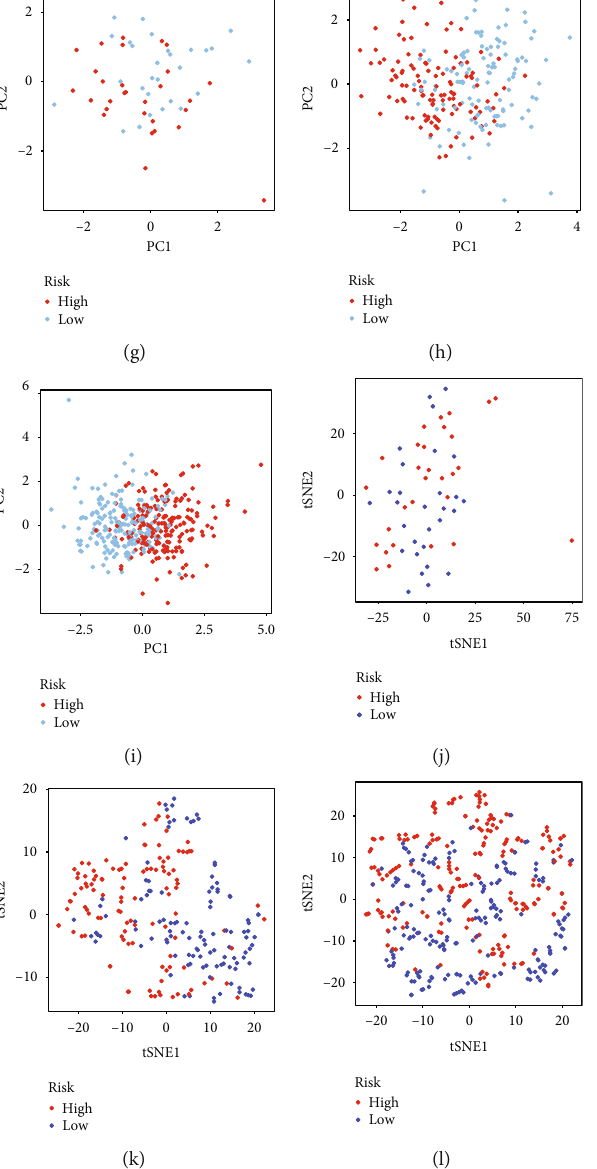
Figure 3: Validation of the signature using GSE3141, GSE31210, and GSE72094. (a – c) Survival analysis of GEO data sets. (d – f) ROC curve of GEO data sets. (g – i) PCA of GEO data sets. (j – l) t-SNE of GEO data sets. (a, d, g, and j) GSE3141. (b, e, h, and k) GSE31210. (c, f, i, and l)